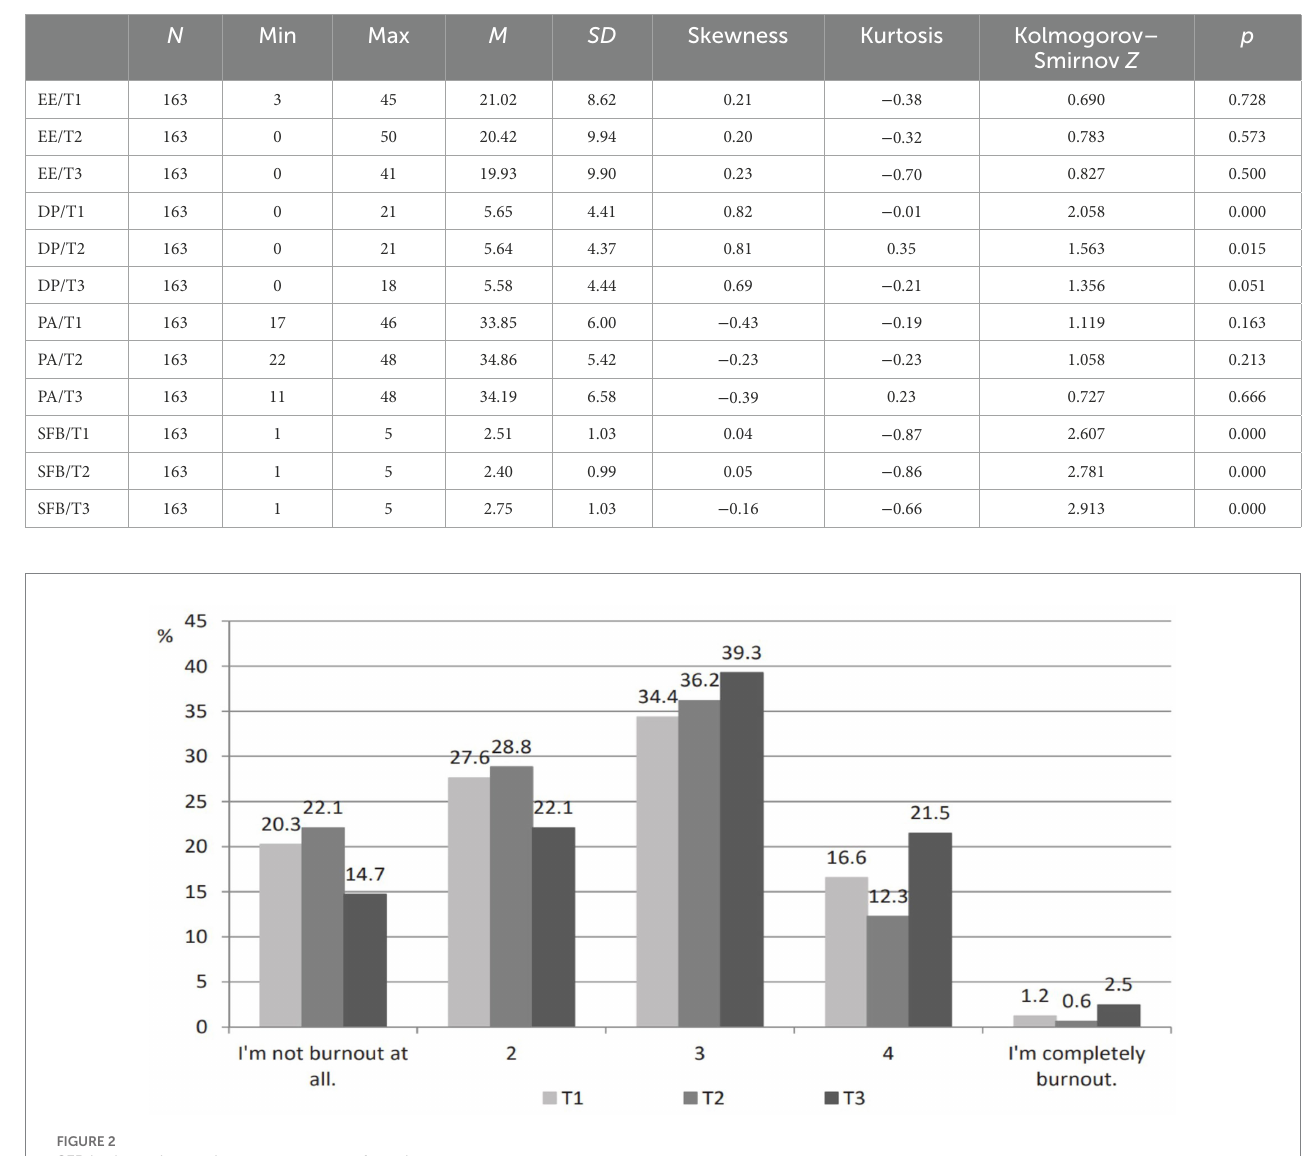
Teachers rated their SFB as low to moderate over the year, similar to MBI scores. The mean score of SFB first decreased from T1 ( M = 2.51, SD = 1.03) to T2 ( M = 2.40, SD = 0.99) and then increased from T2 to T3 ( M = 2.75, SD = 1.03). Differences between measurements during the school year were statistically significant ( χ 2 SFB = 16.055, df = 2, p < 0.001). Post-hoc tests revealed that the difference between T1 and T2 and T1 and T3 was not statistically significant ( Z 1-2 = − 1.509, p = 0.131; Z 1-3 = − 1.757, p = 0.079), while the difference between T2 and T3 was statistically significant ( Z 2-3 = − 4.573, p < 0.001). Figure 2 shows that at T1 and T2, about 15% of teachers have a strong sense of burnout (scores 4 and 5) and about half have a low or no sense of burnout (scores 1 and 2). At T3, the percentage of teachers decreases significantly for low scores